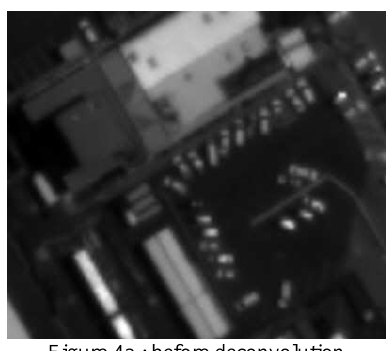
Figure 4a : before deconvolution